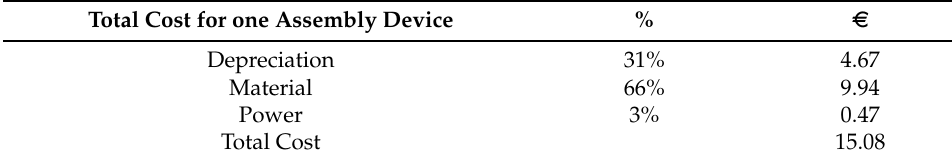
Table 4. Cost allocation and total cost